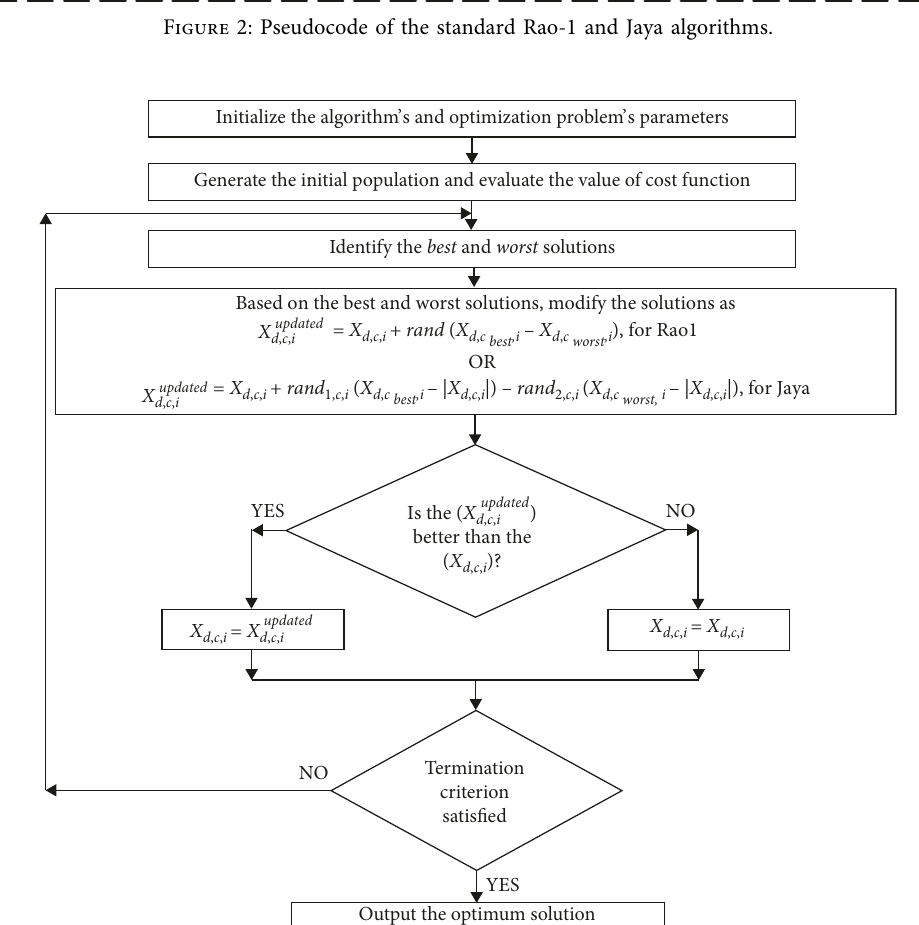
Figure 3: Flowchart of the Rao-1 and Jaya